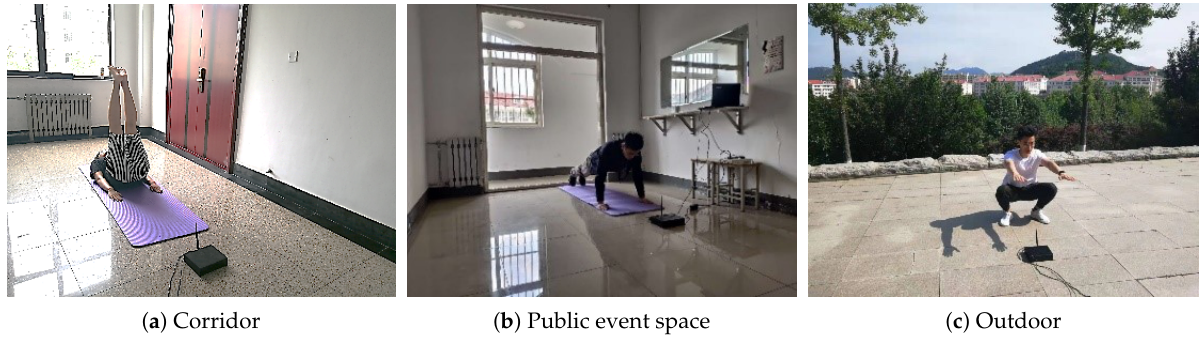
Figure 14. Evaluation scenarios